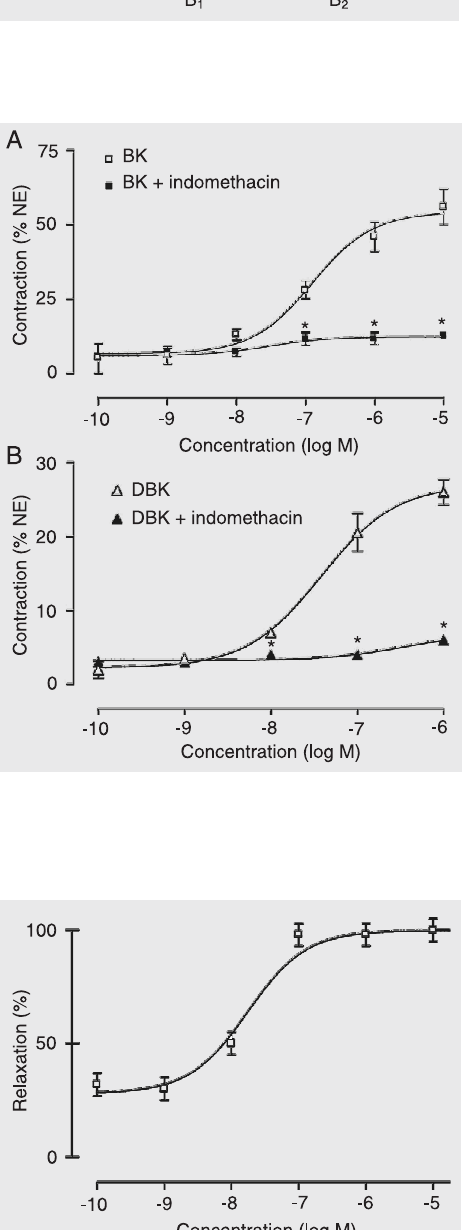
Figure 3. Expression of mRNA for kinin B 1 and B 2 receptors. Gene expression of kinin B 1 and B 2 receptors was determined by real-time quantitative PCR. ß- Actin was used as an internal standard. The 2 - ∆ CT parameter was used to express the rela- tive gene expression data. *P < 0.05 compared to B 1 ( t -test).